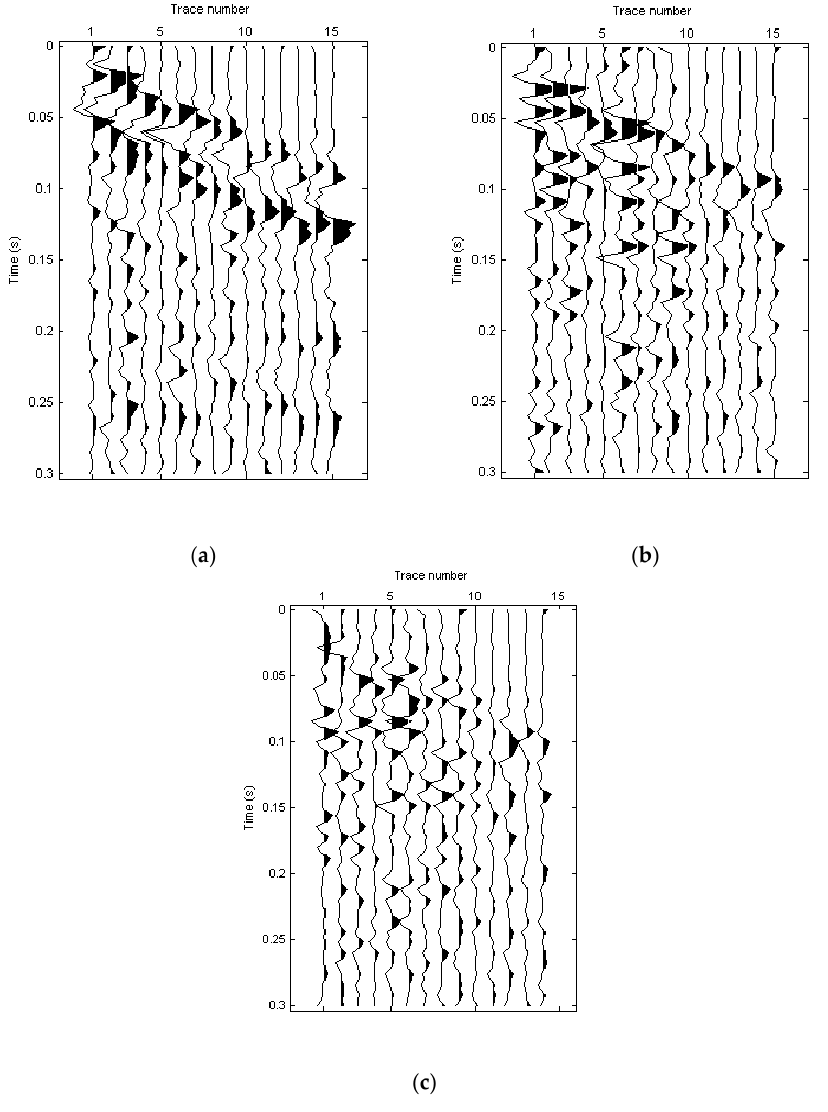
Figure 11. Field seismic data. ( a ) X; ( b ) Z; ( c ) R y .